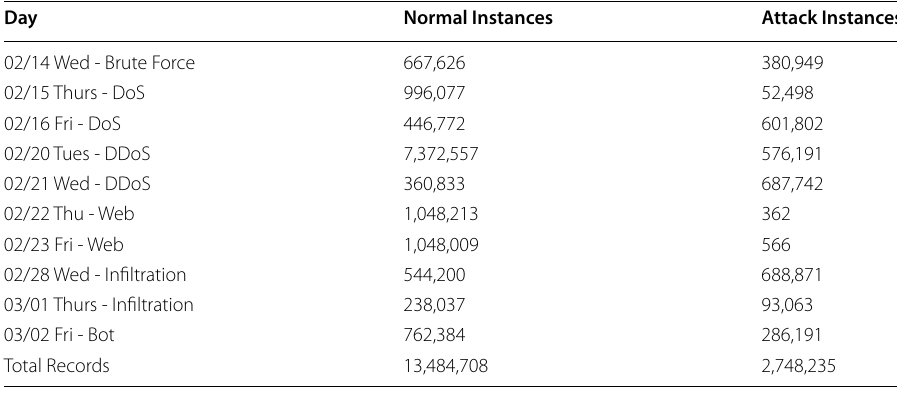
Table 1 CSE-CIC-IDS2018 Dataset by Files